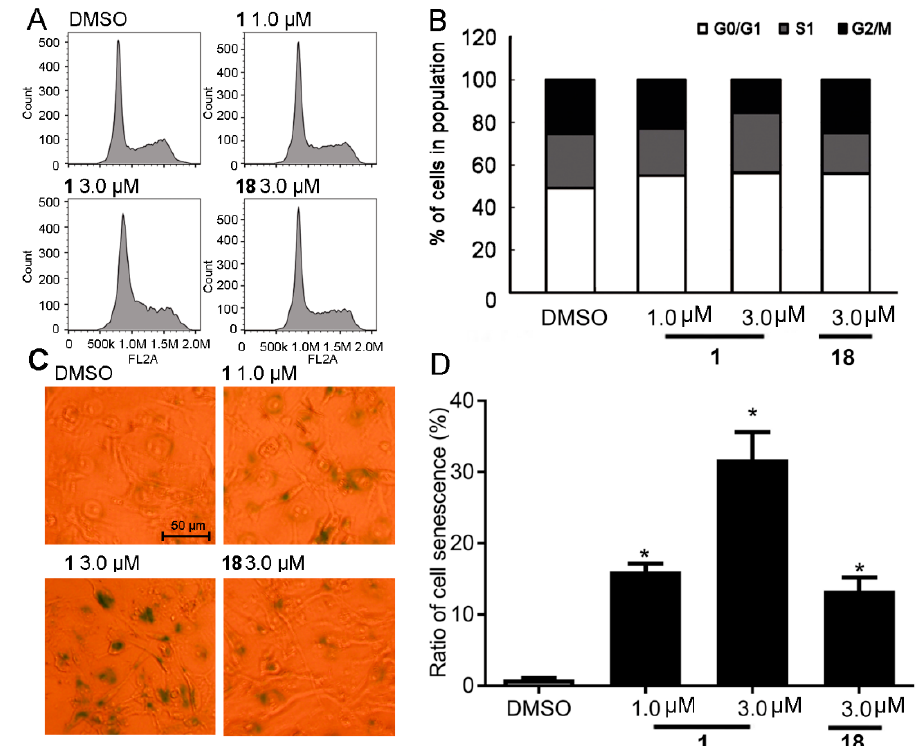
Figure 6. Compound 1 increases G1 population and induces cell senescence in MDA-MB-231 cells. Cells treated with 1 or 18 exhibit an increase entering G1 phase of cell cycle ( A , B ) and ratio of senescence cells ( C , D ) when compared with DMSO control. Data are represented as mean ± SD. Student’s t test, * p < 0.05. scale bar: 50 µm.